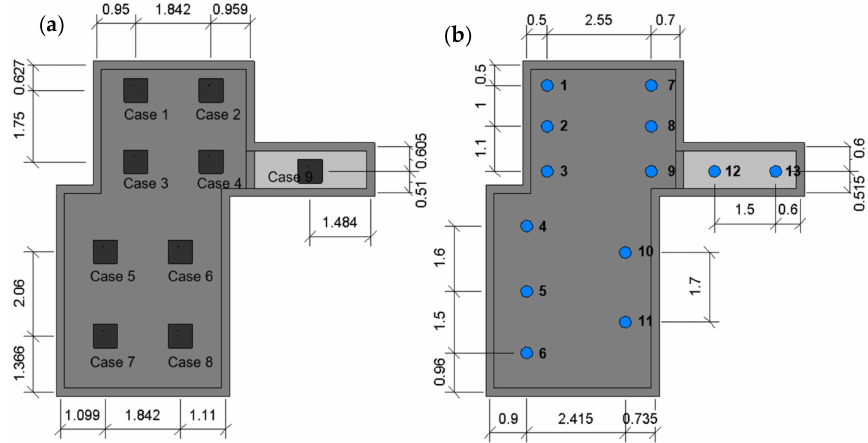
Figure 4. ( a ) Tested locations of the air purifier; ( b ) observation points in the